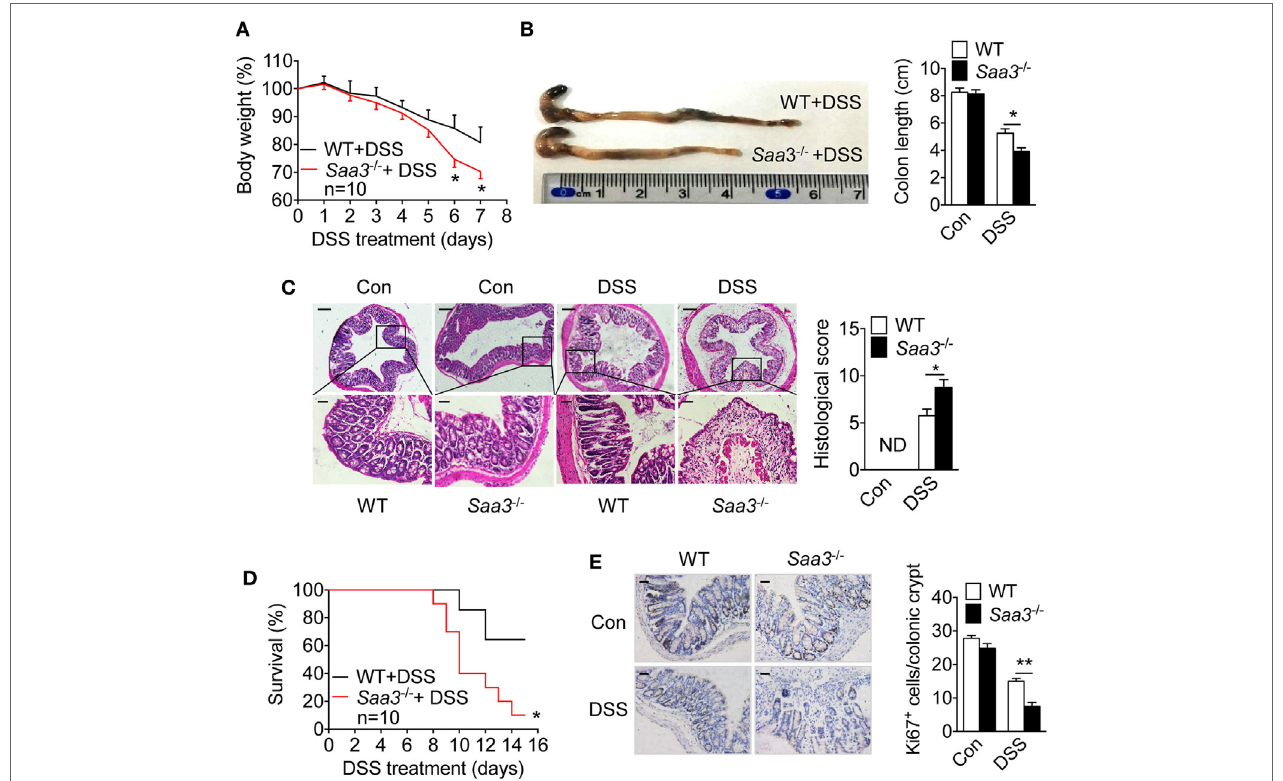
FigUre 2 | Dextran sulfate sodium (DSS)-induced pathological changes in wild type (WT) and Saa3 − / − mice. Male and female mice 8–10 weeks of age were used in the experiments. (a) Body weight change in WT (black) and Saa3 − / − (red) mice ( n = 10) receiving 3.5% DSS in drinking water for up to 7 days. (B) Mice were sacrificed on day 7 and colons were excised. Macroscopic examination of colon lengths in WT and Saa3 − / − mice (left) and statistical analysis of colon lengths (right, n = 5). (c) Representative images of hematoxylin and eosin stained colon sections from control and DSS-treated mice after 7 days. Scale bars, 50 and 20 micrometers in upper and lower panels, respectively. The histological scores of colon pathology are shown in the right panel ( n = 5). (D) Survival rates of mice treated with 3.5% DSS for 7 days followed by normal drinking water for another 8 days ( n = 10 each). (e) Representative images showing proliferative cells (Ki67 + ) in colon of mice with DSS-induced colitis. Quantification of Ki67 + cells in each crypt is shown in right panel ( n = 5). Scale bars, 20 micrometers. All quantitative data are mean ± standard margin of error based on triplicate measurements. * p < 0.05 and ** p < 0.01 between WT and Saa3 − / −